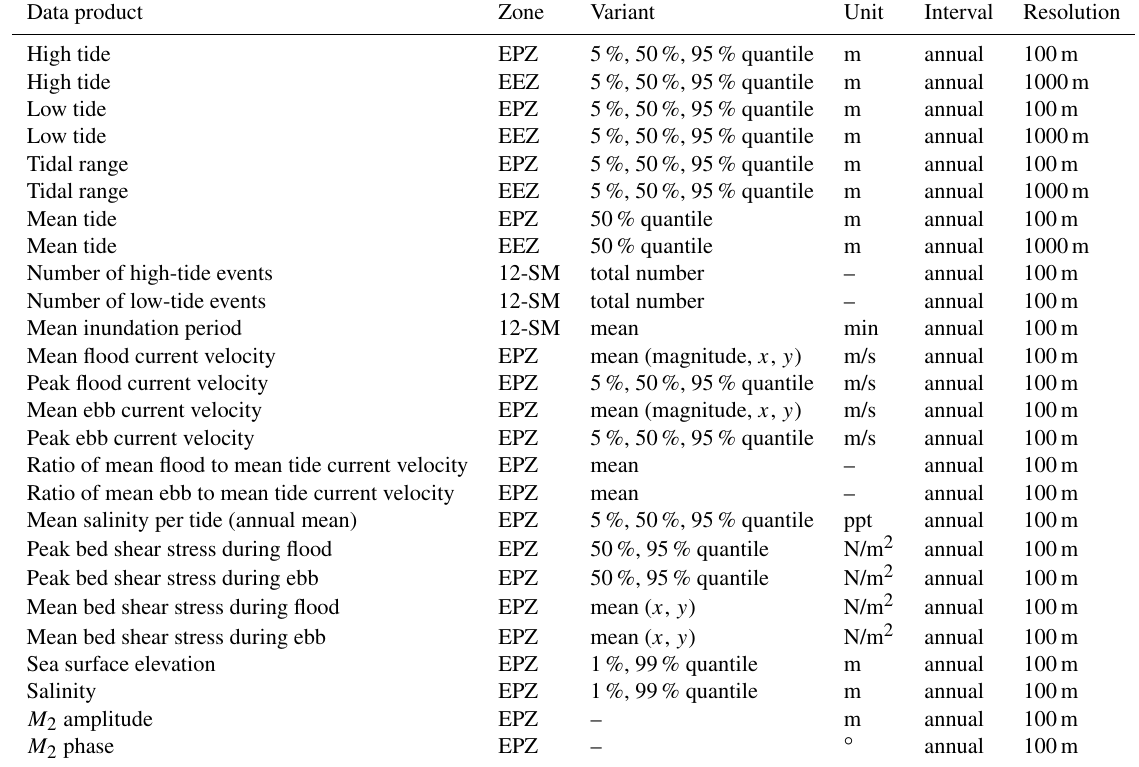
Table A3. Tidal characteristic and harmonic data analysis